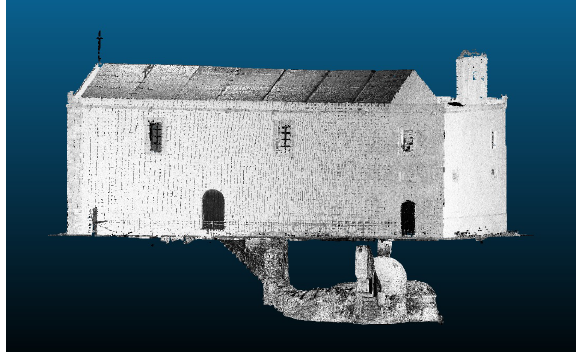
Figure 11. Final point cloud of the terrestrial laser scanner survey.